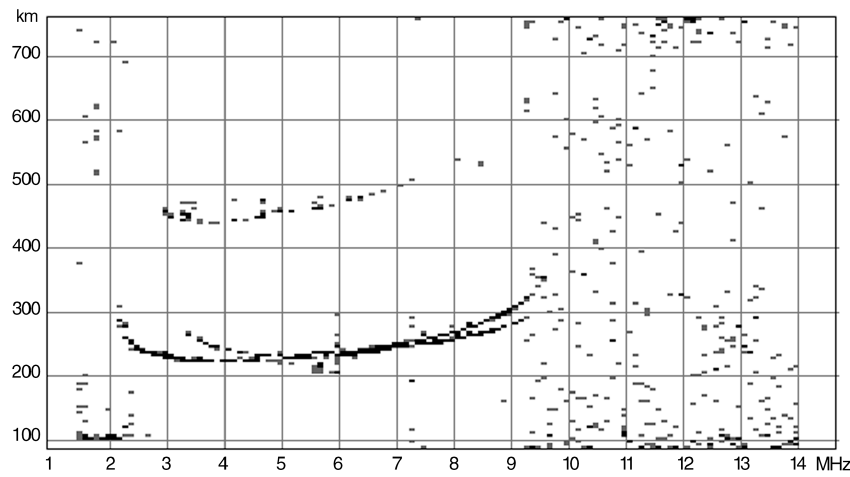
Fig. 3. An example of ionogram belonging to the subset B . The ionogram trace is abruptly truncated, so the op- erator is not able to scale the critical frequency f 0 F 2. In this case the software identifies the trace correctly and so the MUF(3000) F 2 is correctly scaled (33.0 MHz the value automatically scaled, and 33.0 MHz by the oper- ator). The value of f 0 F 2 = 10.3 MHz given by the program is